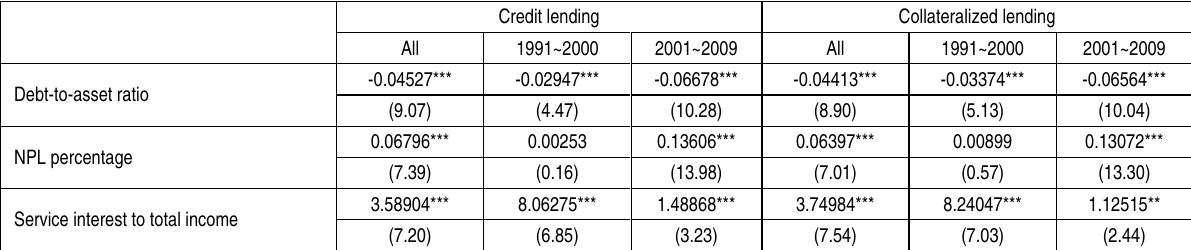
Table 6. Credit lending and collateralized lending market shares – adding macroeconomic